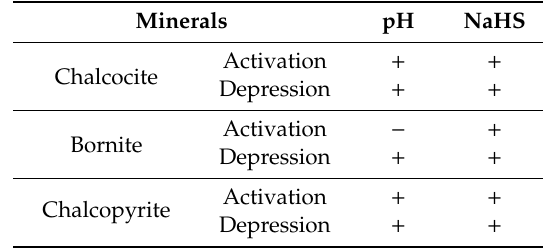
Figure 9. Final copper recoveries without NaHS and with NaHS dosages of 50 g/t, 100 g/t, and 200 g/t at pH 8, 9, and 10.